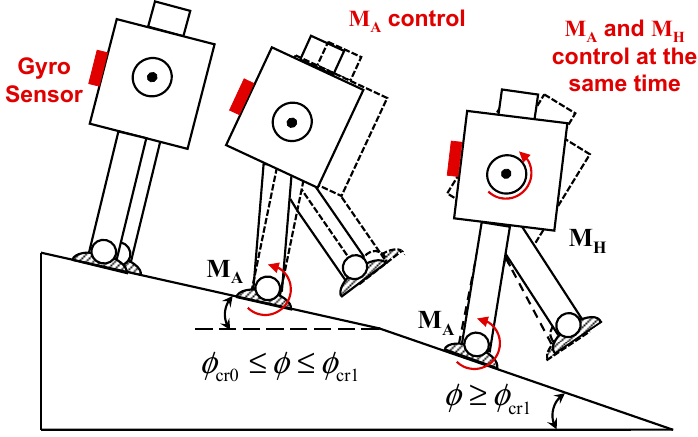
Figure 2. The gyro sensor measured angular-pitch velocity of the robot body is used to control the ankle-pitch motor (M A ) above a critical inclination φ cr0 and is then used additionally to control the hip-pitch motor (M H ) above a larger critical inclination φ cr1 , in order to balance the robot walking.